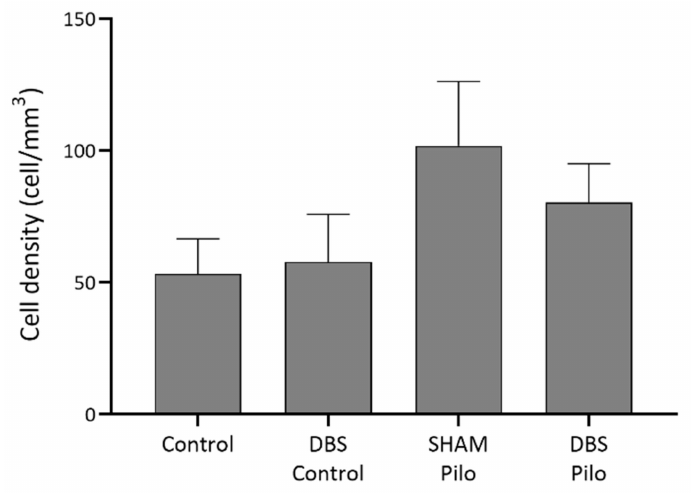
Figure 7. NPY+ cell density in the CA1 region of the hippocampus. No significant differences were observed among the groups, despite that Pilo animals had higher densities. Data are presented as means ± SEM.